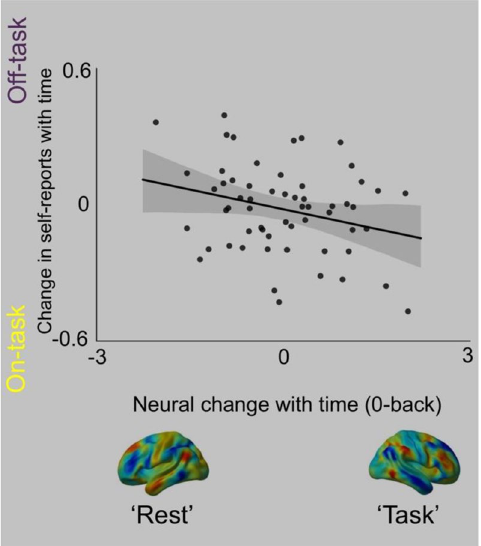
Figure 4. Greater neural shift towards task-negative regions during the 0-back task are associated with greater off-task thought. The horizontal axis of the scatter plot indicates the association between patterns of off-task thought and time. The vertical axis of the scatterplot indicates the change along the task positive hierarchy (Gradient 3) with the passage of time during the 0-back task. It can be seen that individuals who show the greatest shift away from task-positive regions during the 0 back task with time also show the strongest increase in off-task thought over